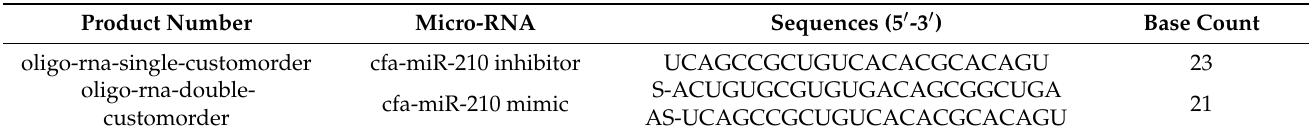
Table 1. Micro-RNA-210 sequence for